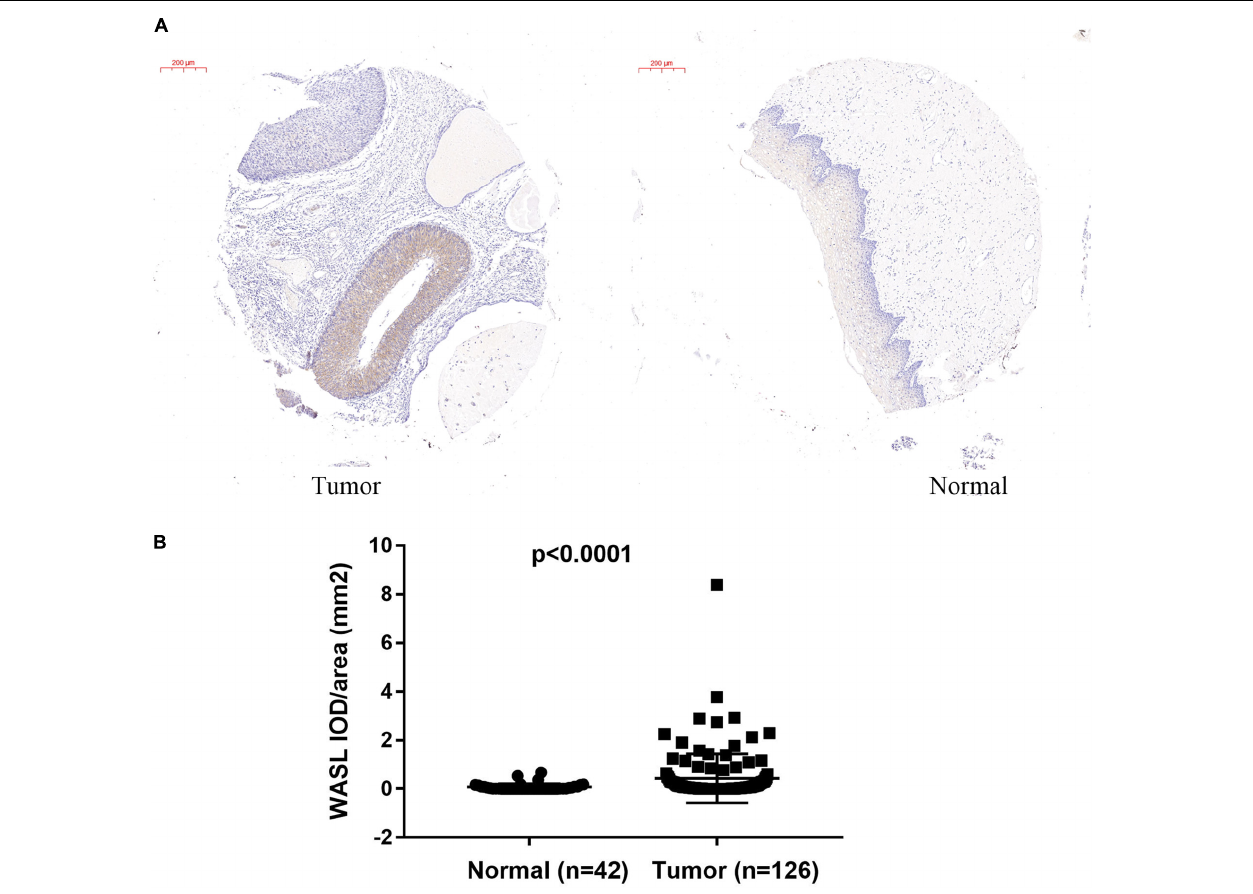
FIGURE 1 | Immunohistochemistry (IHC) staining in tissue microarray showing increased WASL protein level in cervical cancer tissues. The representative images of IHC are shown in (A) , while the quantification of WASL protein level is summarized in (B) . Scale bar in (A) , 200 µ m. Student’s t -test was performed and data represent means ± SEM in (B) . P < 0.0001.